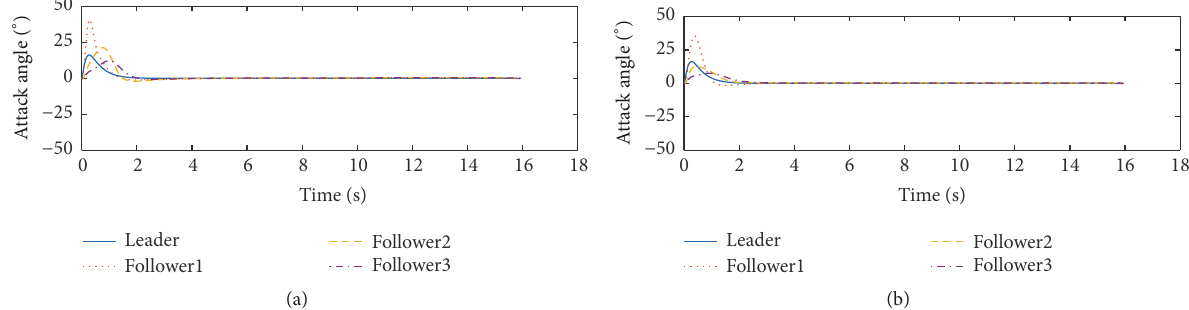
Figure 8: Attack angle curve in the global and local communication topologies: (a) attack angle curve in the global communication topology; (b) attack angle curve in the local communication topology.